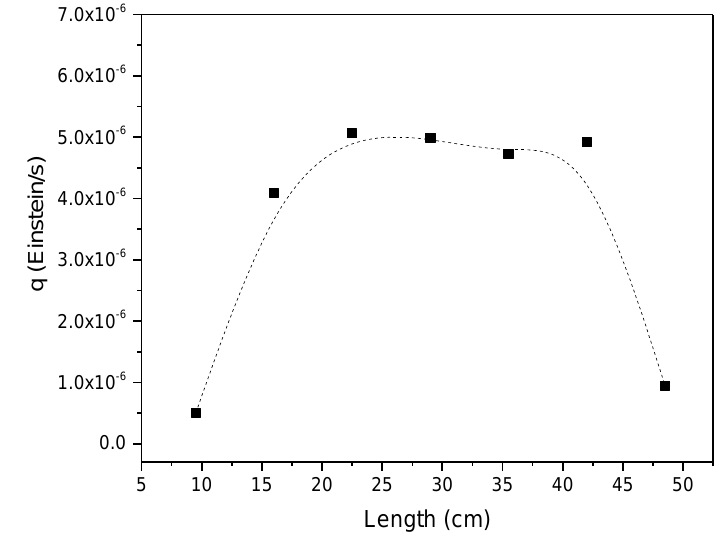
Figure A2. Near-UV Lamp Axial Distribution. Figure A17. Near-UV Lamp Axial Distribution .